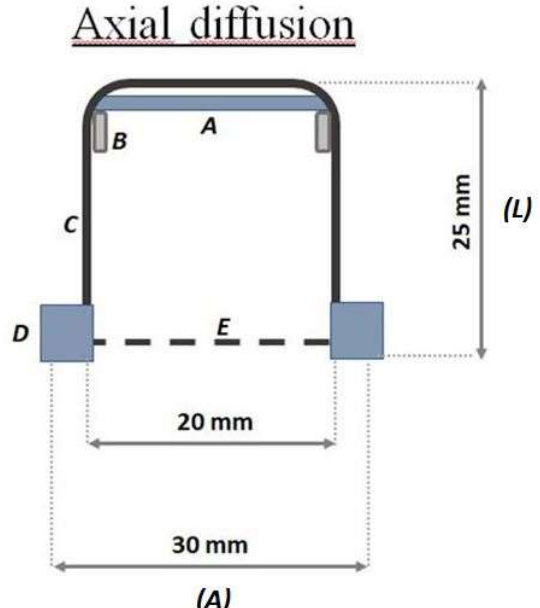
Figure 1. Schematic representation of the axial sampler. Adsorbent nanostructured material (A), teflon o-ring (B), glass cylinder (C), teflon cap (D) teflon net (E). Three Radial diffusive bodies made of polyethylene (PE) with a microporous structure, 1.5 mm